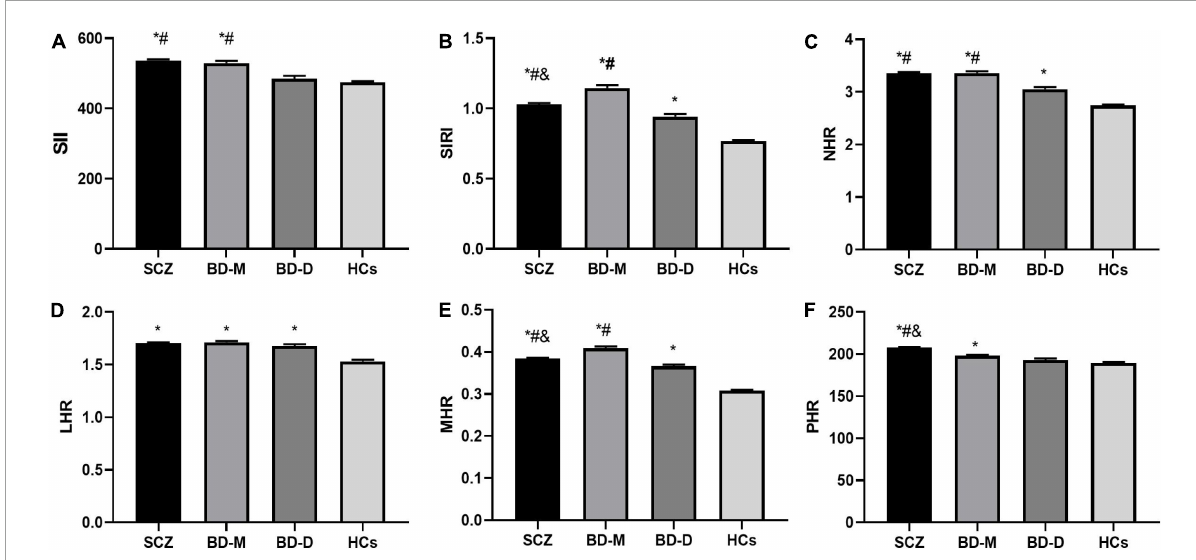
FIGURE1 Comparison of inflammation ratios among SCZ, BD-M, BD-D, and HCs. (A) Comparison of SII; (B) comparison of SIRI; (C) comparison of NHR; (D) comparison of LHR; (E) comparison of MHR; (F) comparison of PHR. Data are represented as the mean ± SEM; * vs. HC group, P < 0.05; # vs. BD-D group, P < 0.05; & vs. BD-M group, P < 0.05. SCZ, schizophrenia; BD-M, bipolar disorder manic episodes; BD-D, bipolar disorder depressive episodes; HC, healthy control; SII, systemic immune-inflammation index; SIRI, system inflammation response index; NHR, neutrophil/HDL ratio; LHR, lymphocyte/HDL ratio; MHR, monocyte/HDLratio; PHR, platelet/HDLratio.